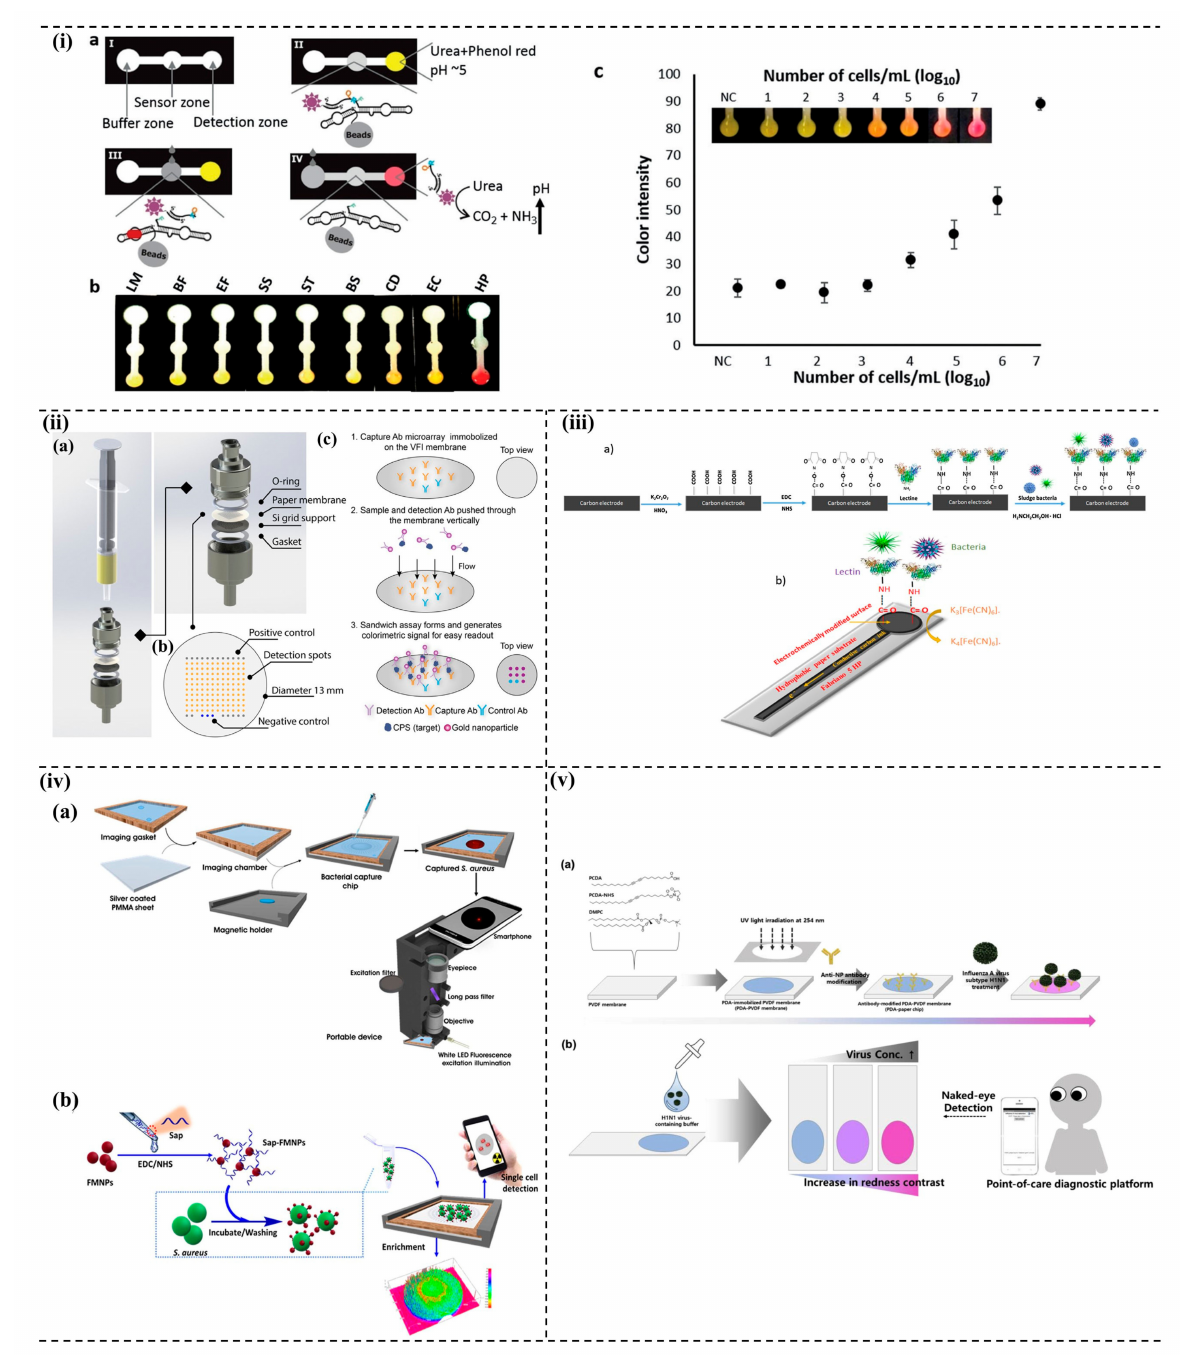
Figure 6. Emerging detection approach for pathogen. ( i ) ( a ) Colorimetric detection of H. pylori